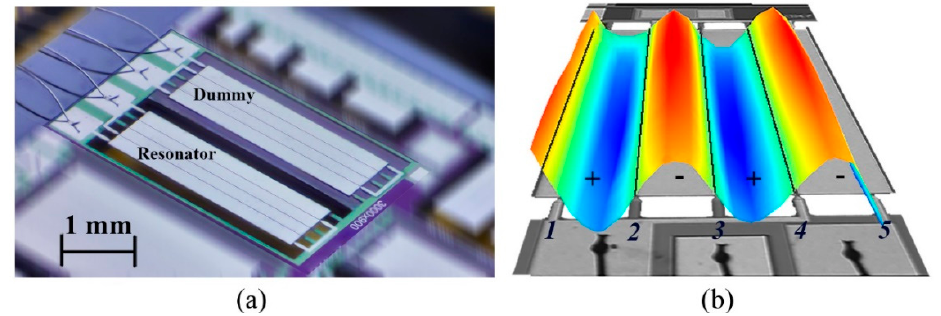
Figure 1. ( a ) Top-view micrograph of the resonator (3000 μ m × 900 μ m × 10 μ m) and compensation device in a dual in-line package. ( b ) Modal shape measured with a laser Doppler vibrometer (0 5- mode ).